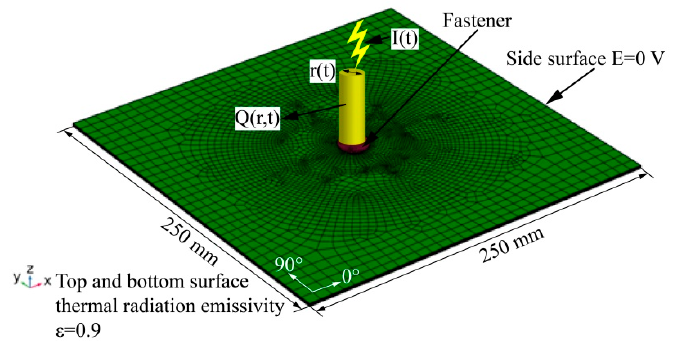
Figure 4. Finite element model and boundary conditions.